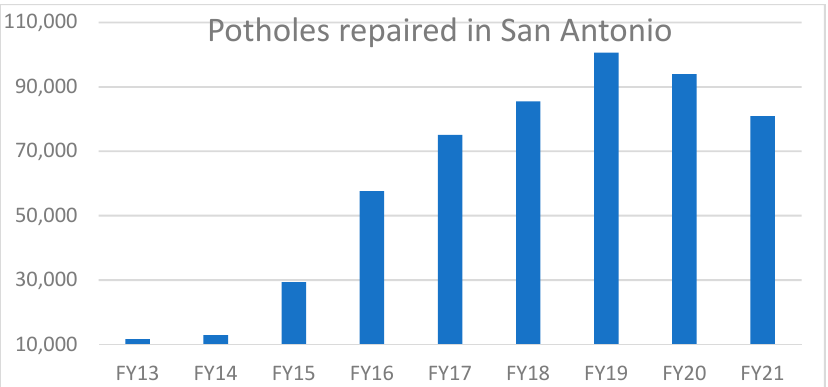
Figure 1. Annual number of potholes repaired From FY13 to FY21 in San Antonio, TX, USA drawn from data in [4,5].